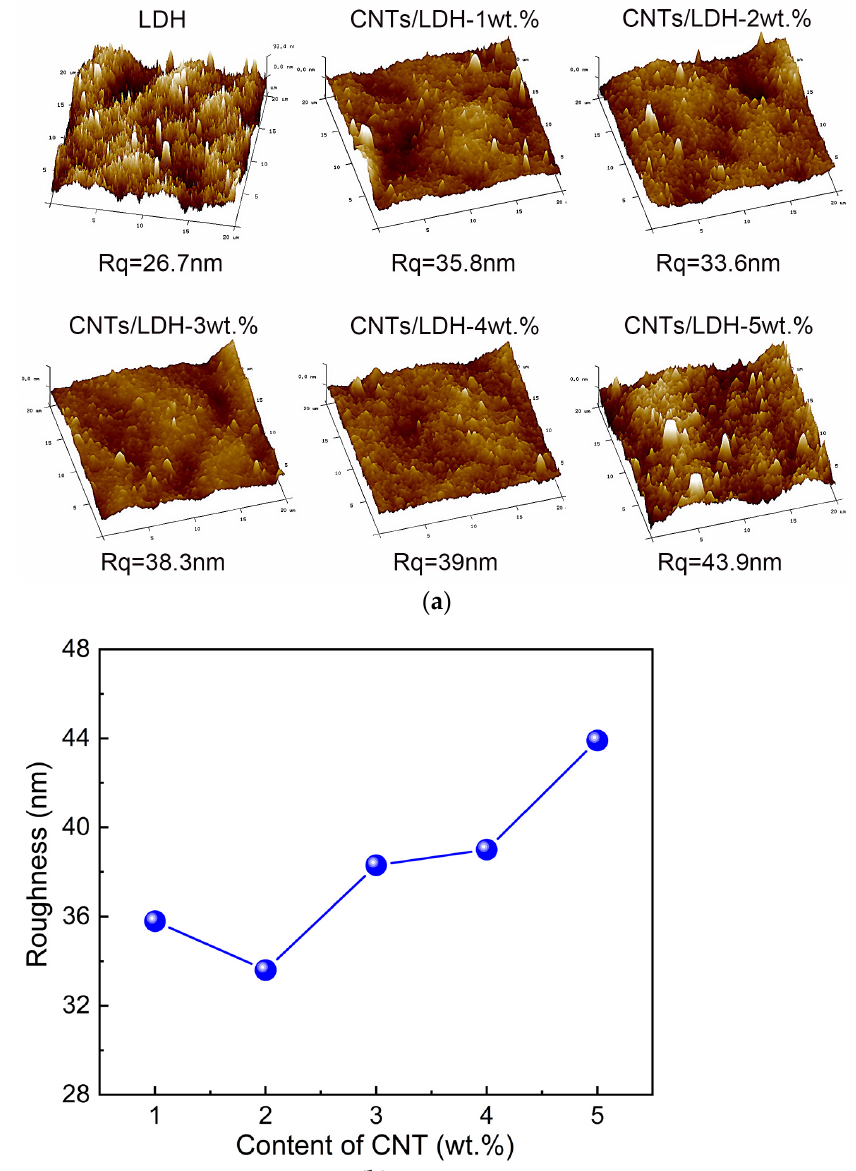
Figure 4. ( a ) AFM images of LDH and CNTs/LDH membranes; ( b ) surface roughness of CNTs/LDH composite membranes with different CNT contents (1 wt.%–5 wt.%).